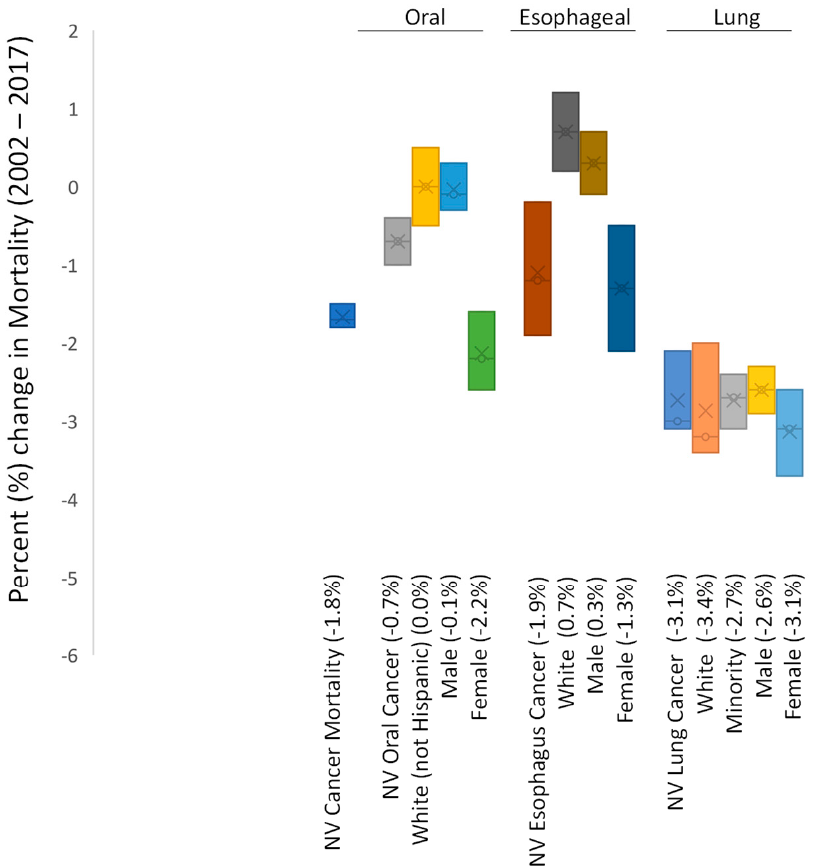
Figure 2. Analysis of smoking-related cancer mortality rates in Nevada 2002 − 2017. Differential results revealed declining rates of oral cancer mortality ( − 0.7%) strongly associated with females ( − 2.2%), as well as declining rates of esophageal cancer mortality ( − 1.9%) also associated mainly with females ( − 1.3%). Declining rates of lung cancer mortality ( − 3.1%) were observed with similar rates among males and females ( − 2.6%, − 3.1%, respectively). Note: insufficient data were available to analyze or plot non-White oral and esophageal cancer mortality in Nevada.